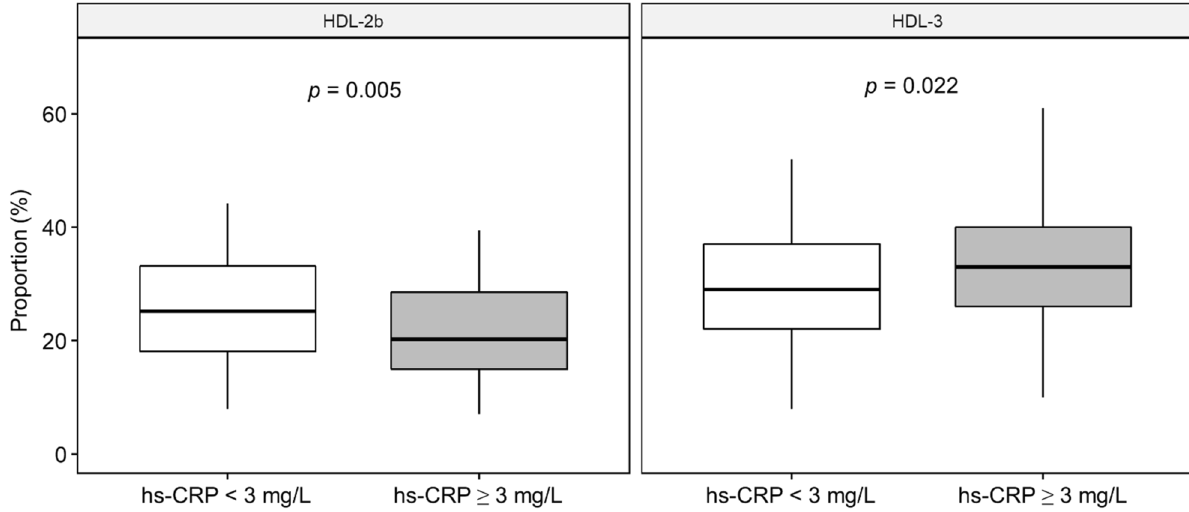
Figure 2. Proportion of the HDL-2b and HDL-3 subclasses in patients with hemodialysis stratified by an hs-CRP concentration 3